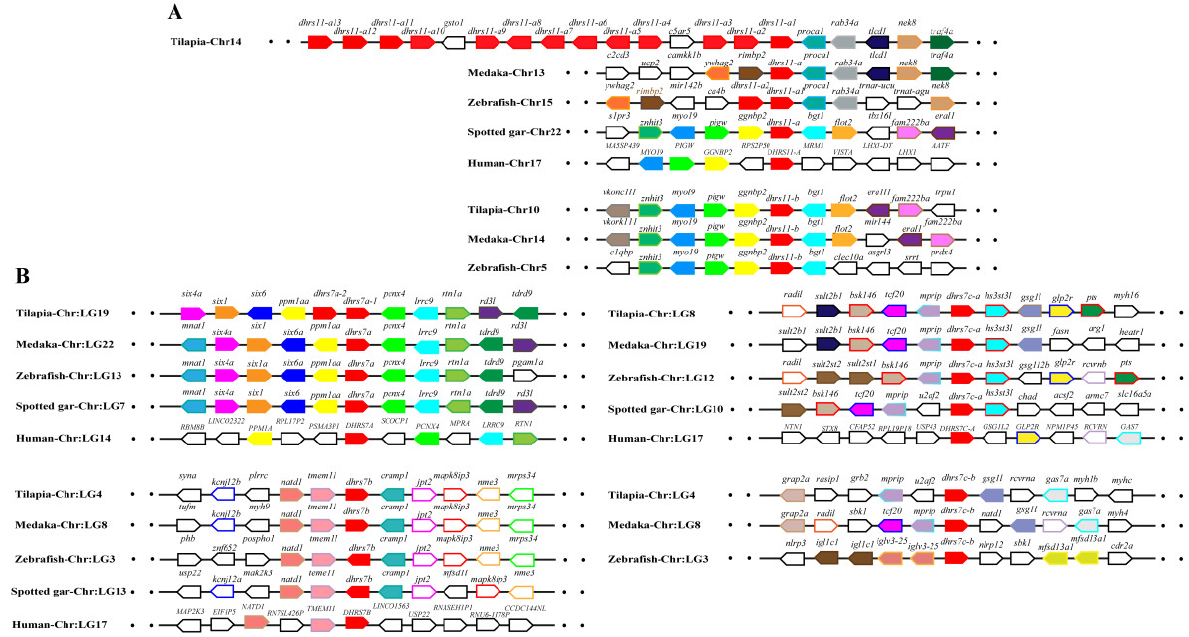
Figure 5. Syntenic analysis of dhrs11 ( A ) and dhrs7 ( B ) and their adjacent genes in Nile tilapia and other vertebrates. Rectangles represent genes in chromosome/scaffold. Dots represent omitted genes of the chromosome/scaffold. The direction of the arrows indicates the gene orientation. The SDR s are shown in red, while the other genes are shown in different colors.